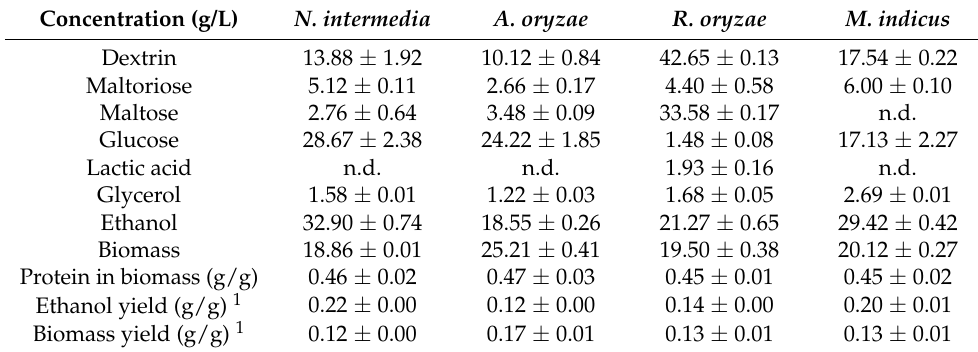
Table 2. Comparison of the fermentation effects by four edible fungi strains after 72 h cultivation on bread hydrolysate